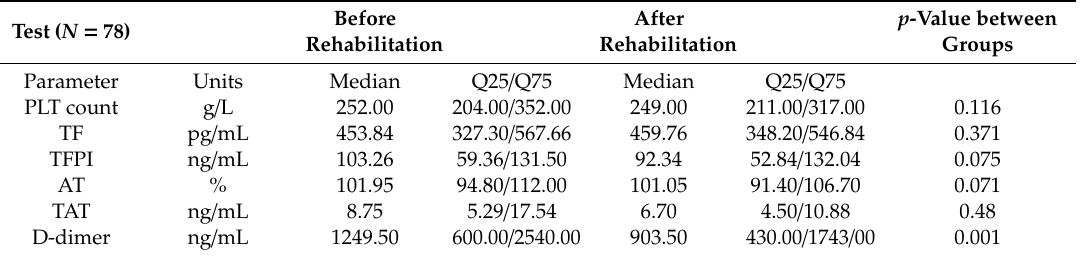
Table 3. Parameters of hemostasis in the study subjects before and after a four-week rehabilitation program.